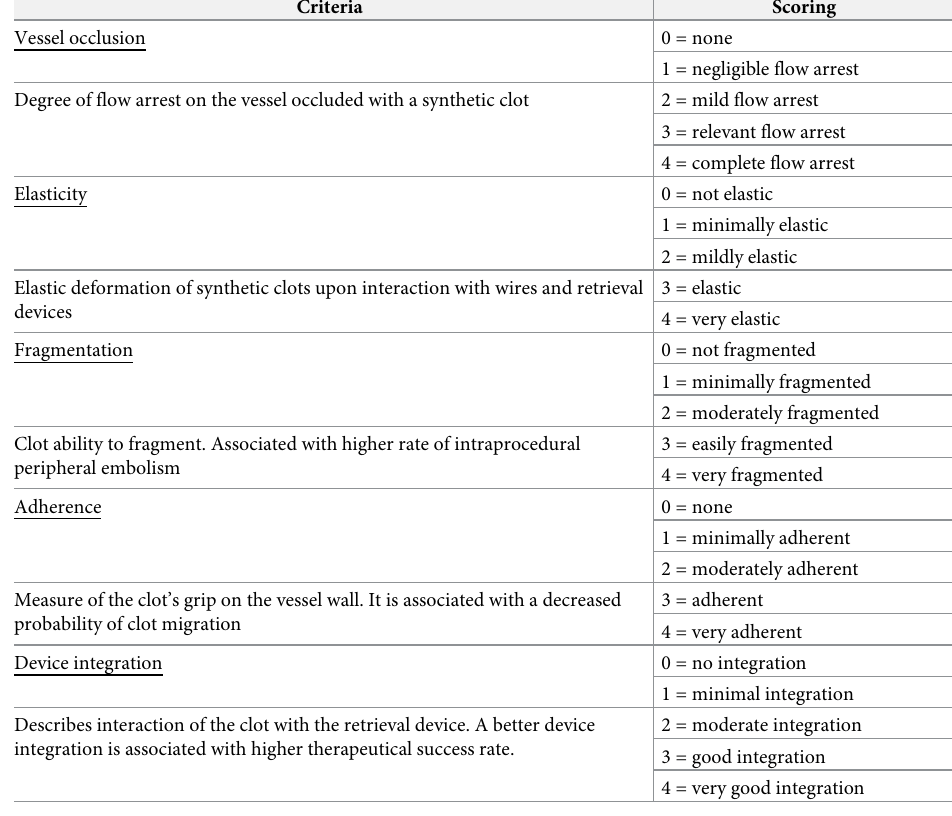
Table 2. Classification scale for the qualitative evaluation of synthetic clot characteristics in an in-vitro experi- mental